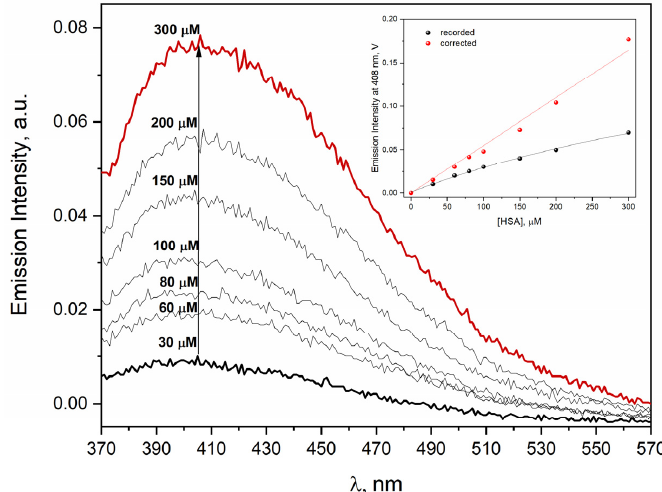
Figure 1. Emission spectra of the neat HSA solutions (30–300 µM). The excitation wavelength was 320 nm. Insert: Dependence of I max as a function of HSA concentration before and after inner filter effect correction. I max —intensity of HSA emission in buffer solution at maximum of emission band, λ exc = 320 nm. Emission intensity correction procedure is described in Materials and Methods.